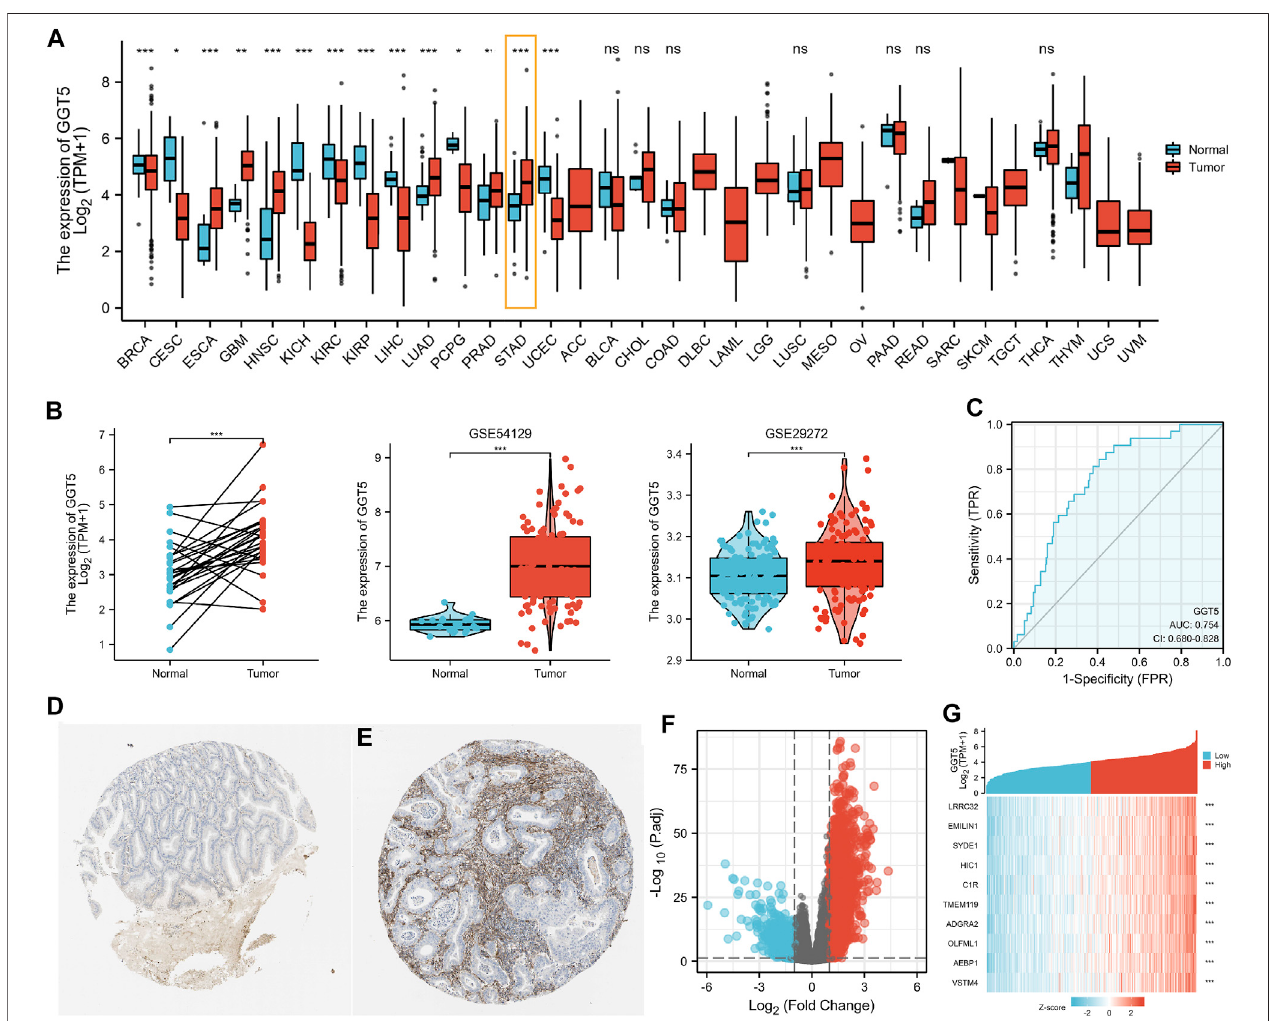
FIGURE1| Pan-canceranalysisof GGT5 expressionlevelsandupregulated GGT5 inhumangastriccancer. (A) Detectionoftheexpressionlevelof GGT5 inapan- cancer dataset from TCGA. (B) The expression level of GGT5 in gastric cancer compared to paired and normal gastric mucosa from the GEO (GSE54129, GSE29272) and TCGA datasets. (C) ROC curve showing the predictive value of GGT5 for identifying gastric cancer tissues based on the TCGA database. (D,E) Comparison of GGT5 betweennormalgastricmucosa (D) andgastriccancertissue (E) basedontheHumanProteinAtlasdatabase(antibodyHPA008121,10×)(accessiondate: August 2021, https://www.proteinatlas.org/). (F) The volcanoplot presents the GGT5 -related differentially expressed genes (DEGs) based on the TCGA database. Red andbluedotsrepresentupanddownregulatedgenes,respectively. (G) Theheatmapshowsthetop10DEGsrelatedto GGT5 .*, p < 0.05;**, p < 0.01;***, p < 0.001;ns, not signi fi cant, p > 0.05. ACC: adrenocortical carcinoma; BLCA: bladder urothelial carcinoma; BRCA: breast invasive carcinoma; CESC: cervical squamous cell carcinoma and endocervical adenocarcinoma; CHOL: cholangiocarcinoma; COAD: colon adenocarcinoma; DLBC: lymphoid neoplasm diffuse large B-cell lymphoma; ESCA: esophageal carcinoma; GBM: glioblastoma multiforme; HNSC: head and neck squamous cell carcinoma; KICH: kidney chromophobe; KIRC: kidney renal clear cell carcinoma; KIRP: kidney renal papillary cell carcinoma; LAML: acute myeloid leukemia; LGG: brain lower grade glioma; LIHC: liver hepatocellular carcinoma; LUAD: lung adenocarcinoma; LUSC: lung squamous cell carcinoma; MESO: mesothelioma; OV: ovarian serous cystadenocarcinoma; PAAD: pancreatic adenocarcinoma; PCPG: pheochromocytoma and paraganglioma; PRAD: prostate adenocarcinoma; READ: rectum adenocarcinoma; SARC: sarcoma; SKCM: skin cutaneous melanoma; STAD: stomach adenocarcinoma; TGCT: testicular germ cell tumors; THCA: thyroid carcinoma; THYM: thymoma; UCEC: uterine corpus endometrial carcinoma; UCS: uterine carcinosarcoma; UVM: uveal